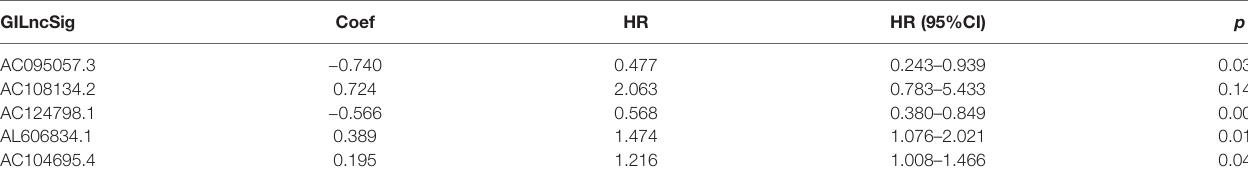
TABLE 1 | Long non-coding RNA signature models associated with genomic instability. GILncSig